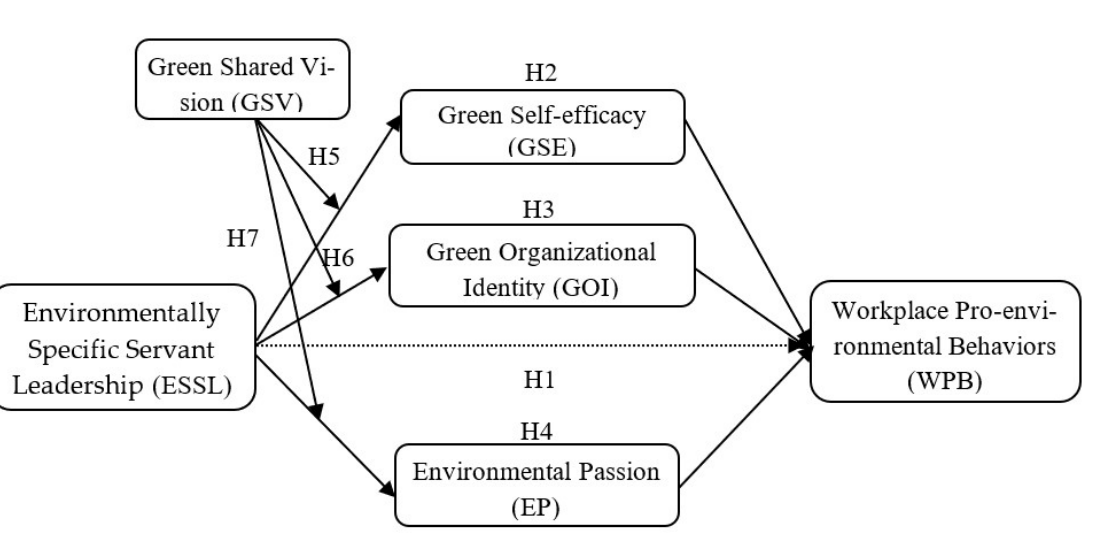
Figure 1. Theoretical model.